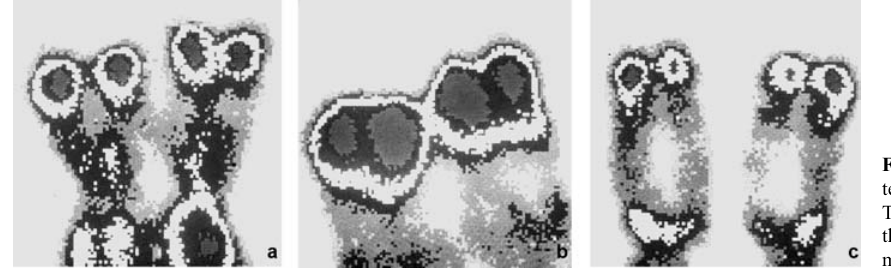
Figure 2 - a - c , Replication high density pat- terns in endoreduplicated CHO chromosomes. The graphic images closely corresponded to the density paterns detected in normal chro-